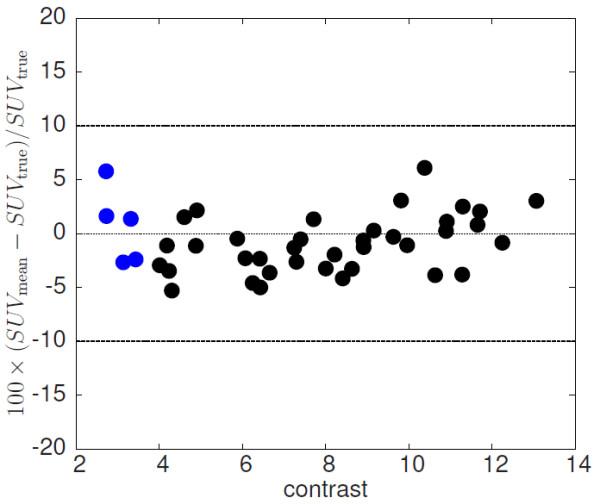
Contrast dependence of difference between LBPVC-corrected and true SUVmean. The blue points represent the subgroup of lesions with artificially reduced contrast